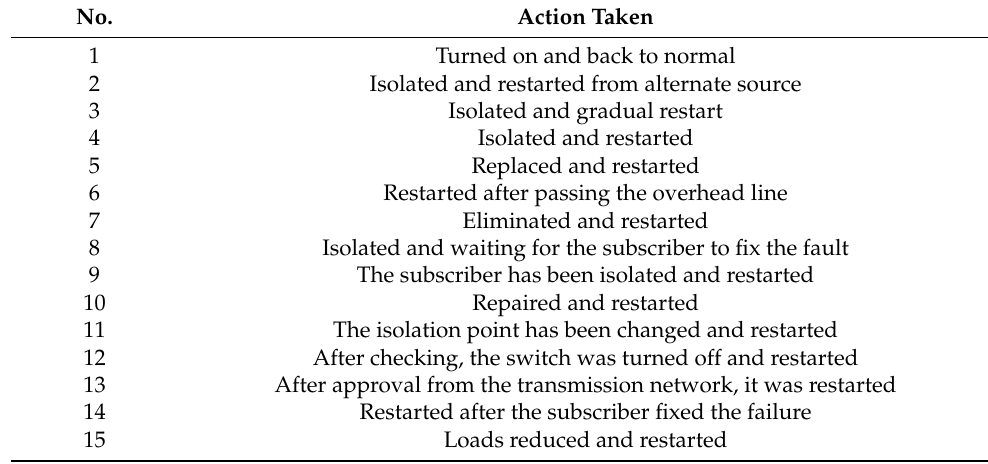
Table 2. Remedial measures or action taken against the faults.